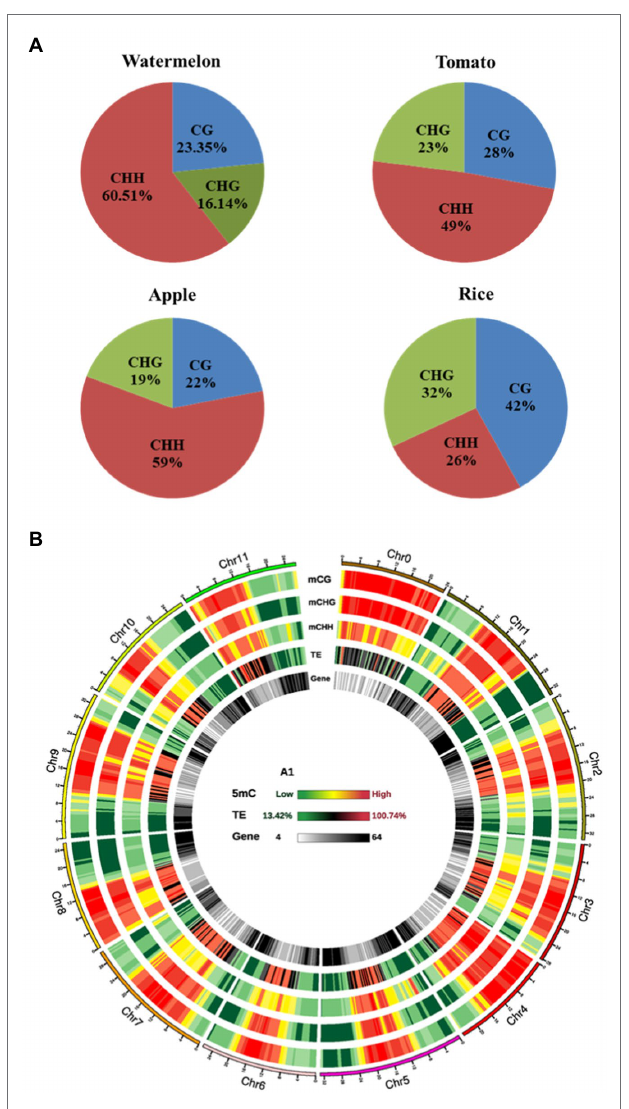
FIGURE 3 | The watermelon epigenome. (A) Relative proportions of mC in three sequence contexts of different species. (B) Circos plot of watermelon chromosomes. Track order: density plot of mC in CG, CHG and CHH contexts; density of TEs; gene density of each chromosome. Red represents hypermethylation while green represents